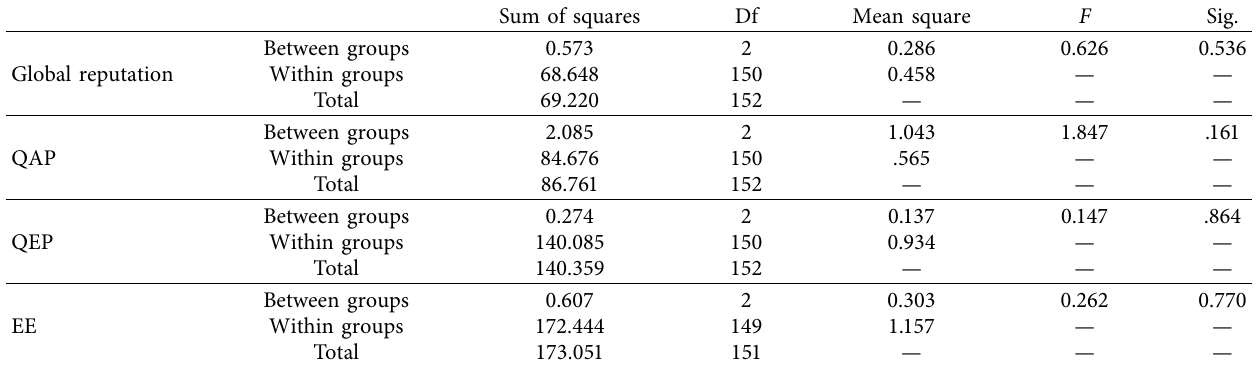
Table 6: ANOVA (gender-based).